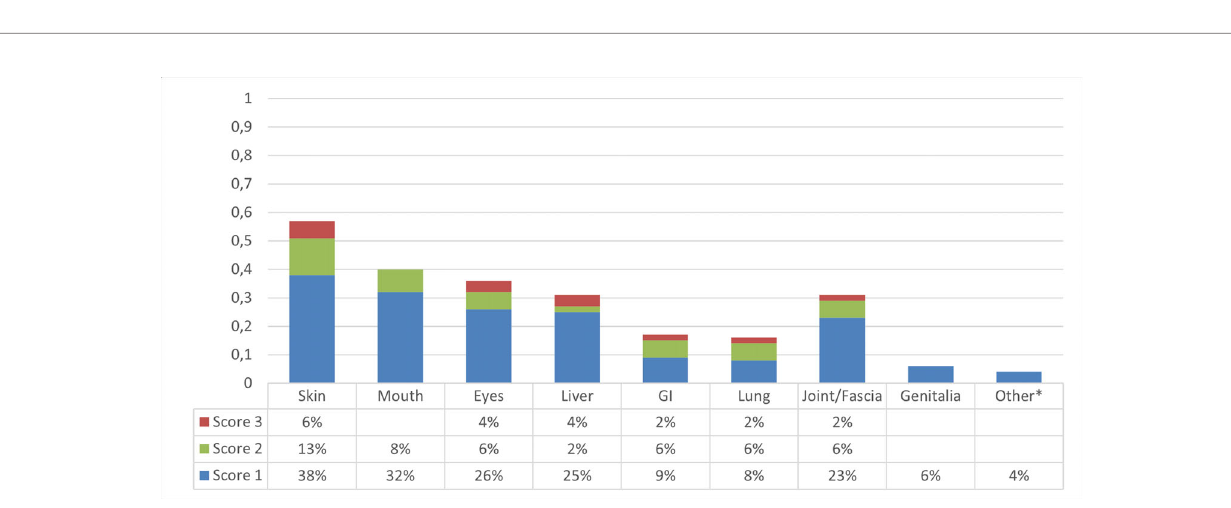
FIGURE 4 | Graphic representation of the distribution of organs involved by chronic graft- versus -host disease (cGvHD) in the overall population. *Renal